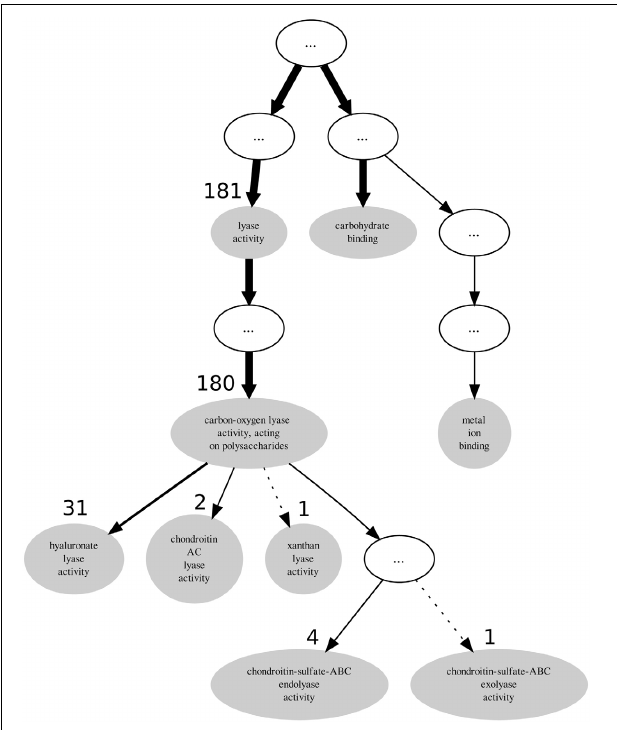
FIGURE 4 | Graph subsuming the GO molecular function aspect annotation of CAZy’s PL8 family.